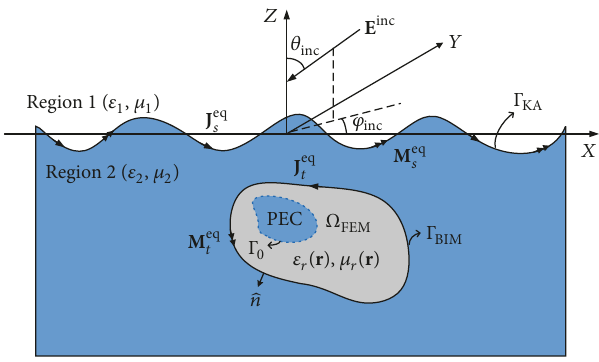
Figure 1: Geometry of the scattering problem of a 3D complex dielectric object buried under a 2D randomly dielectric rough